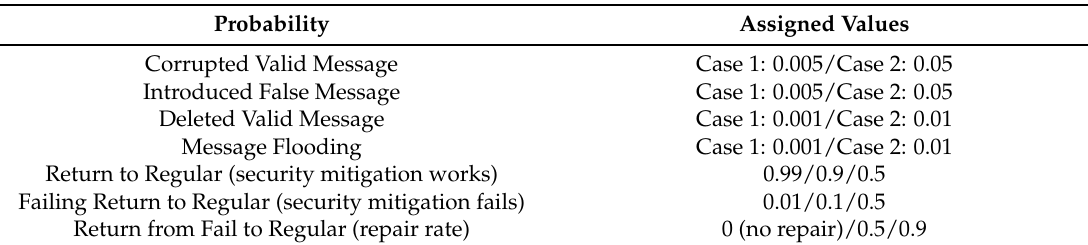
Table 1. Probabilities of transitions.